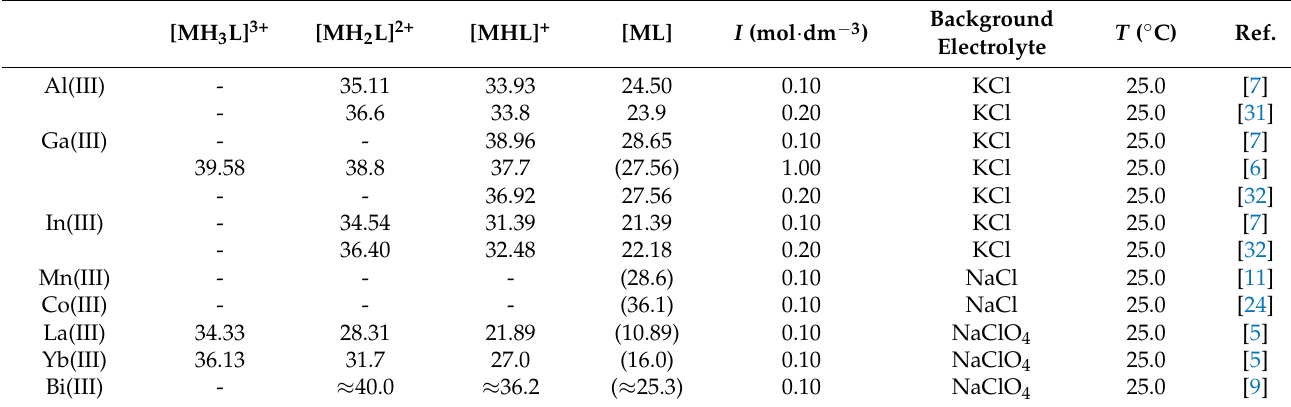
Table 5. Overall complex-formation constants (log β ) of DFOB with trivalent transition metal ions under different exper- imental conditions. The constants in parentheses correspond to the formation of the 1:1 complex of M(III) with DFOB